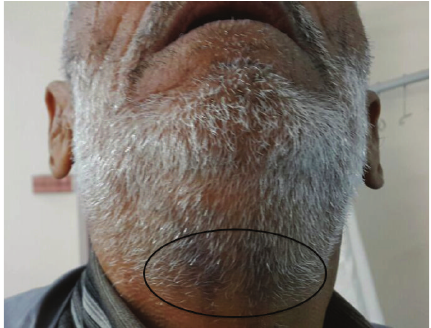
Figure 3: Intestinal submucosal